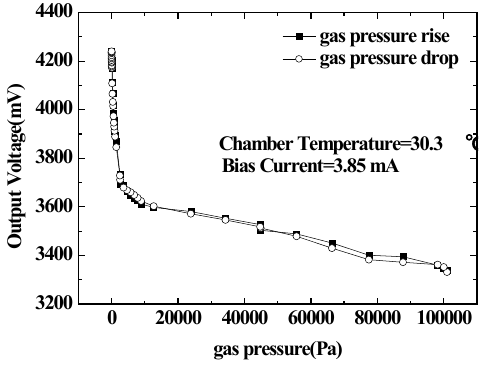
Figure 4. The response of the sensor platform to the gas pressure from 10 − 1 to 10 5 Pa.